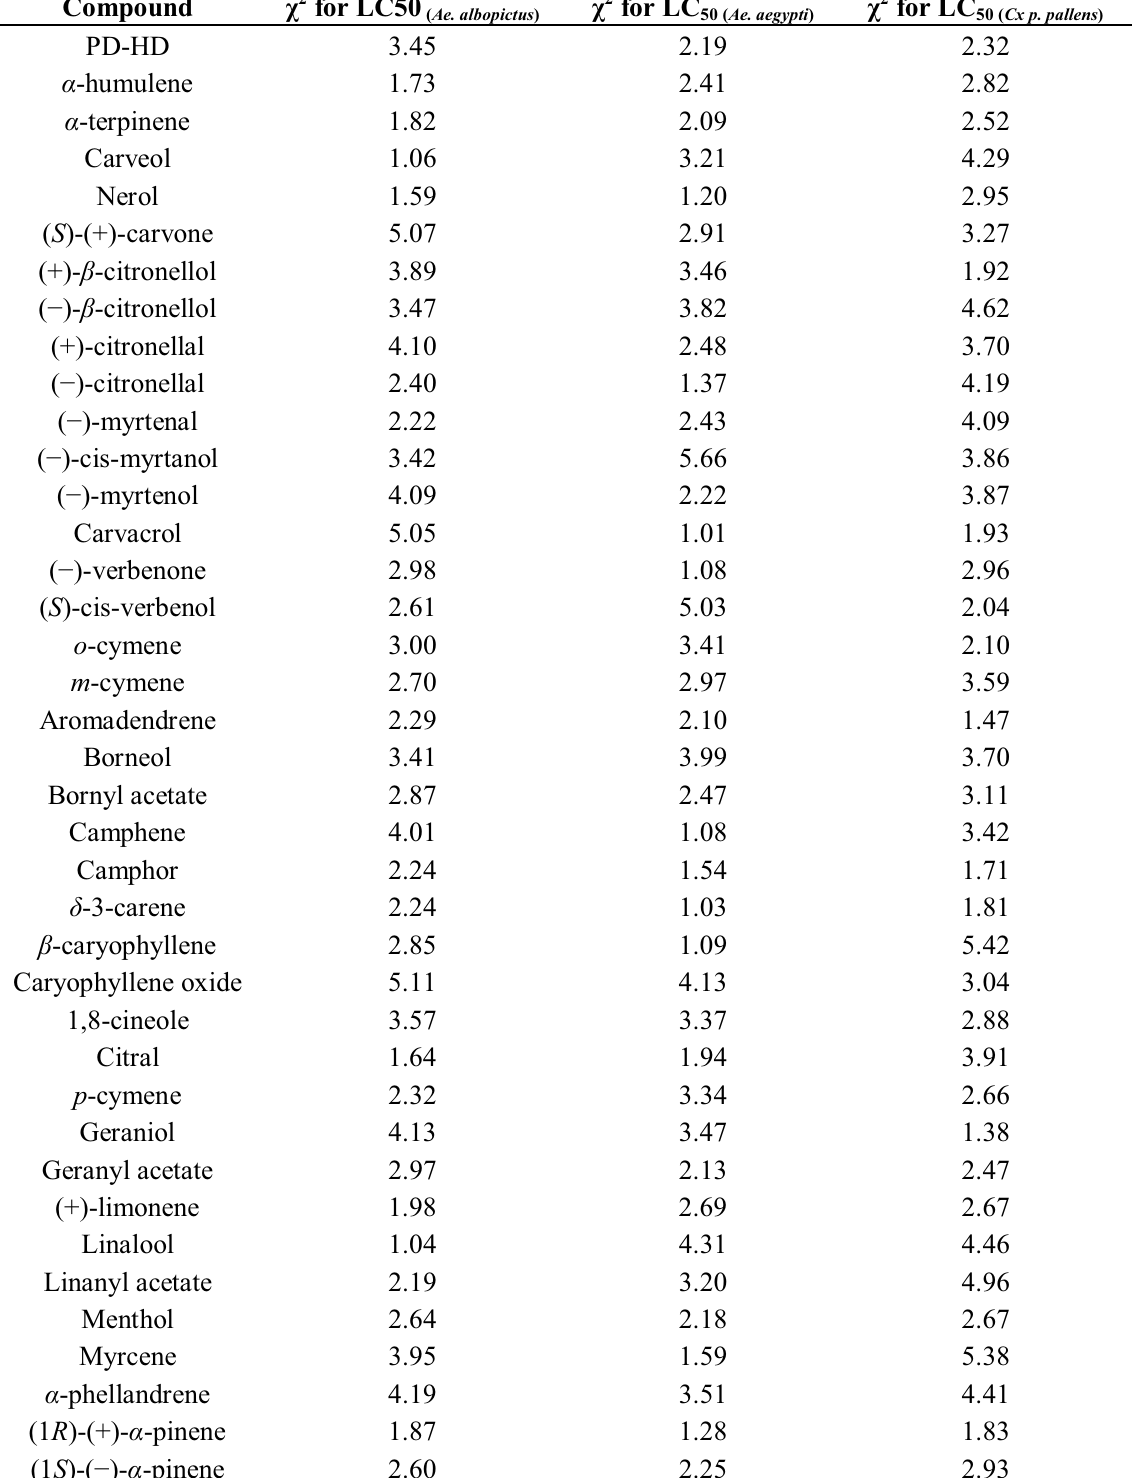
Table 3. Chi-square values for the determined LC